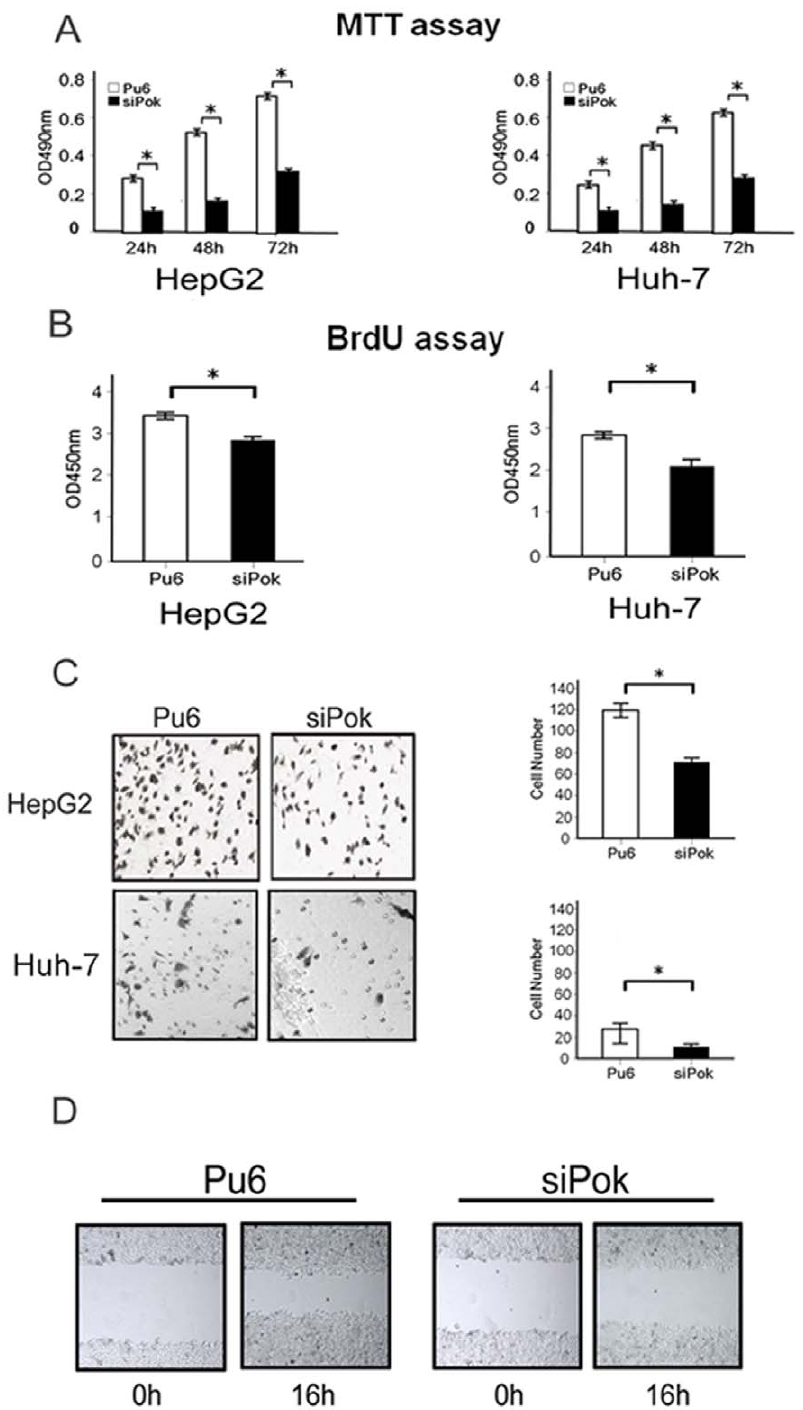
Figure 3. Functional changes in HepG2 and Huh-7 cells induced by Pokemon silencing. ( A ). MTT assay analysis of cell proliferation in HepG2-siPokemon, Huh-7-siPokemon and control cells (* P , 0.01). ( B ). BrdU assay analysis of cell proliferation in HepG2-siPokemon, Huh-7-siPokemon and control cells after 24 hours of incubation (* P , 0.01). ( C ). Representative photographs from the migration assay and a histogram of the quantification of HepG2-siPokemon, Huh-7-siPokemon and control cells (* P , 0.01). ( D ). Representative photographs from the wound healing assay in HepG2-siPokemon and control cells. doi:10.1371/journal.pone.0051916.g003 measured the tumor size every 3 days. Our results indicated that mice transplanted with HepG2-Pu6 cells (n= 8, * P , 0.01). the growth rates of tumors in nude mice that received transplants Western blot analysis of protein extracted from the tumor tissues of HepG2-siPokemon cells were significantly lower than those in showed that the Pokemon knockdown was maintained in the